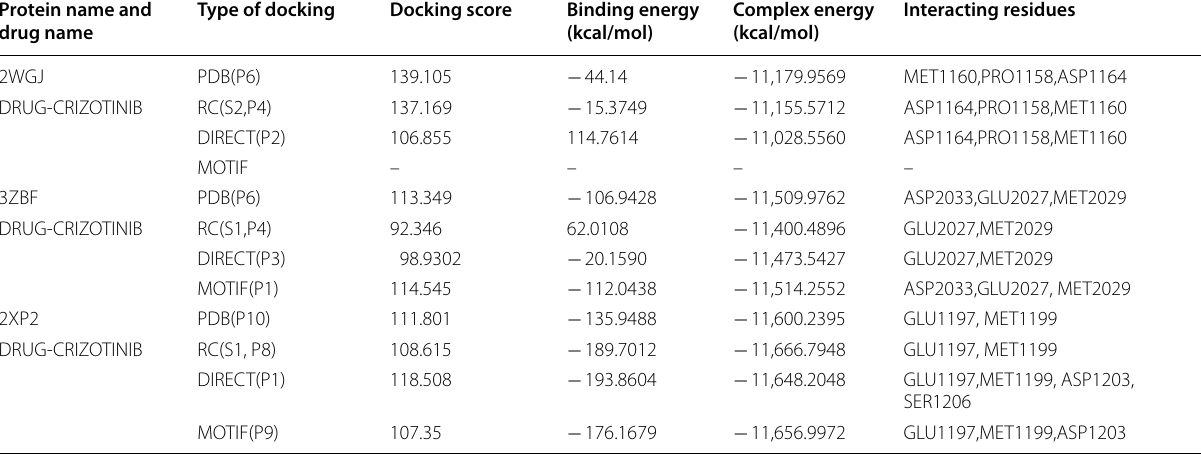
Table 4 The details of the druggable binding site, their docking score and binding energy, least complex energy and the main interaction showed amino acid residues at the binding site Protein name and drug